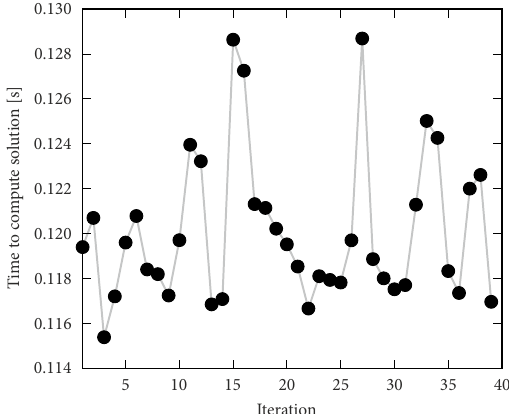
Figure 8. Time taken per iteration: segmented algorithm testing